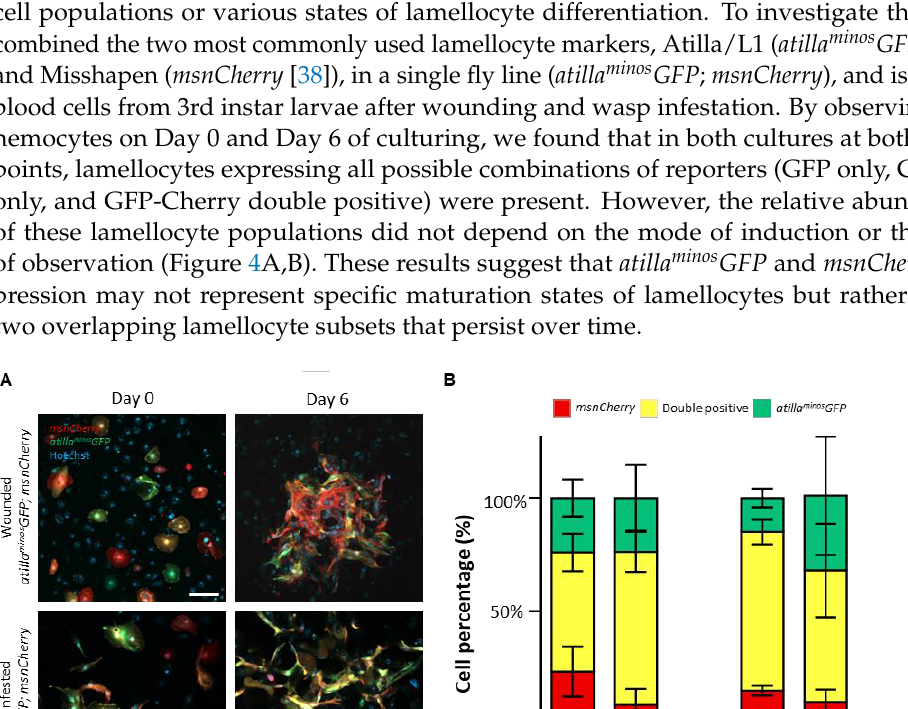
Figure 3. Proliferation and transdifferentiation in ex vivo hemocyte cultures. ( A ) Representative im- ages of naive, wounded, and wasp-infested Cg > Fly-FUCCI cultures on Day 1 and Day 4 (green: cells in G1 phase, red: cells in S phase, yellow: cells in G2/M phase). Scale bar: 50 μm. ( B ) Bar graph showing the percentage of cells in G1, S, and G2/M phase in hemocyte cultures derived from naive, wounded, and wasp-infested Cg > Fly-FUCCI larvae. Cells in three fields of view at a 10x objective were counted from each sample (n = 3), and the data are the mean ± SD of three independent exper- iments. Data were analyzed using ANOVA with Tukey ’ s test for multiple comparisons, * p ≤ 0.05 ( C ) Representative images of hemocyte cultures of naive, wounded and wasp infested Me , and tu- morous Me; l(3)mbn 1 , Me,hop Tum and Me; Hml>Pvrλ on Day 1 of culturing (green: plasmatocytes, red: lamellocytes), arrows indicate transdifferentiating cells expressing both eaterGFP and msnCherry . Scale bar: 20 μm. ( D ) Bar graph showing the percentage of transdifferentiating cells (ratio of eaterGFP and msnCherry double positive cells to the total cell number in the culture) in naive, wounded, and wasp infested Me , and tumorous Me; l(3)mbn 1 , Me,hop Tum and Me; Hml>Pvrλ on Day 1 and Day 4 of culturing. Cells in three fields of view at a 10x objective were counted from each